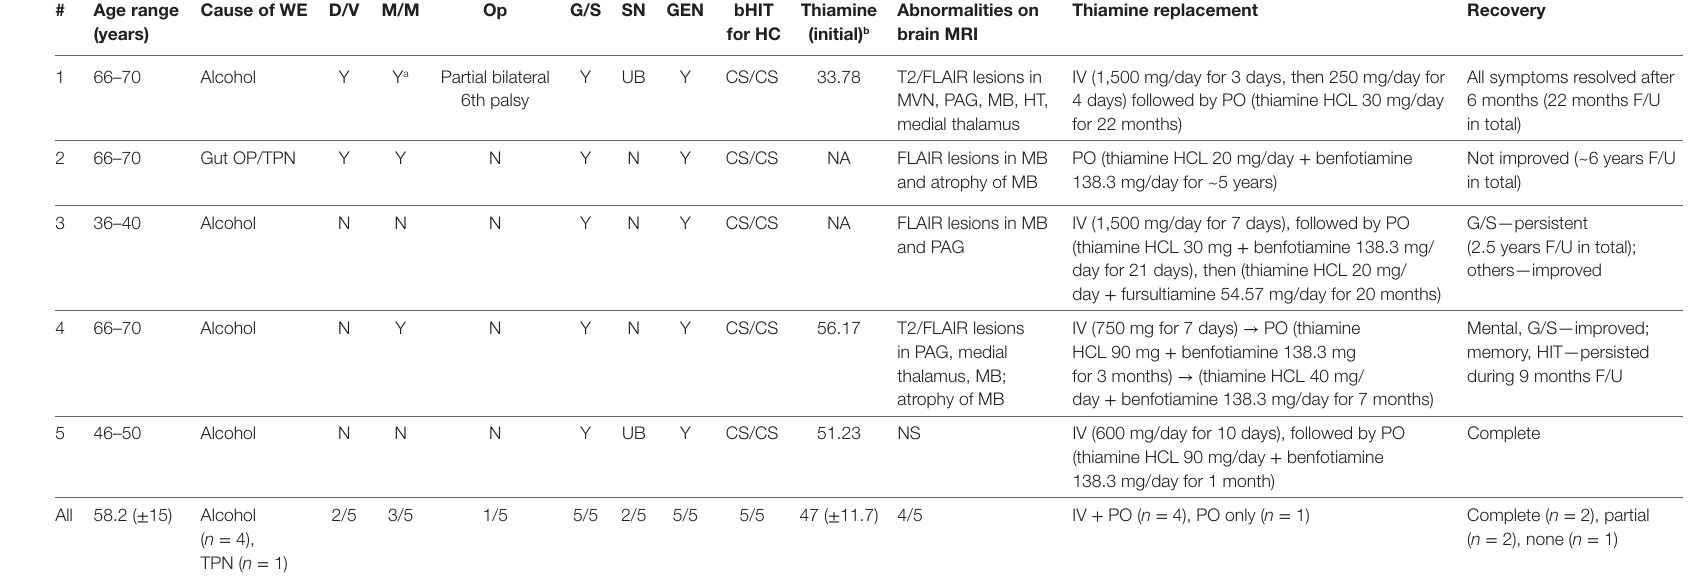
TaBle 1 | Demographical and clinical findings of five patients with WE. # age range